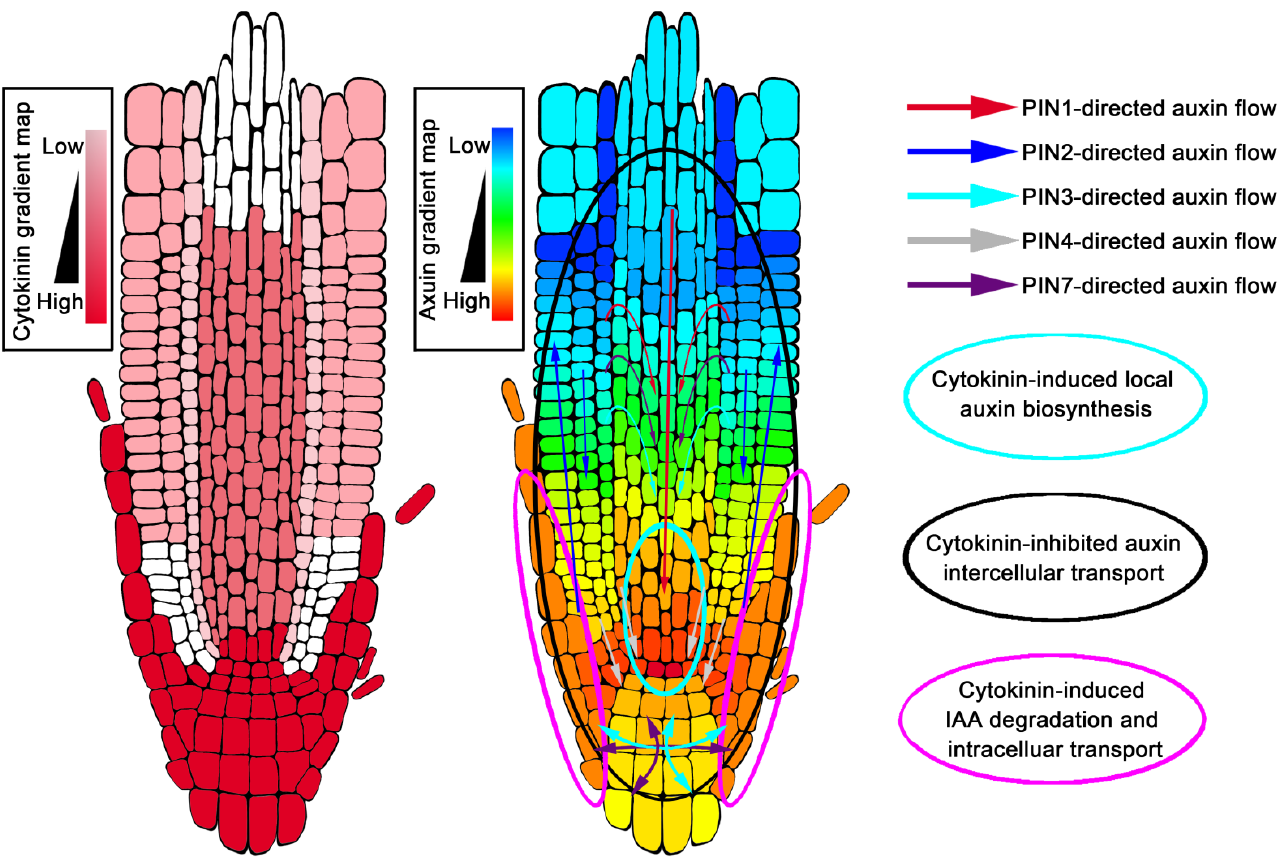
Figure 2. Cytokinin-controlled gradient distribution of auxin in Arabidopsis root tip.